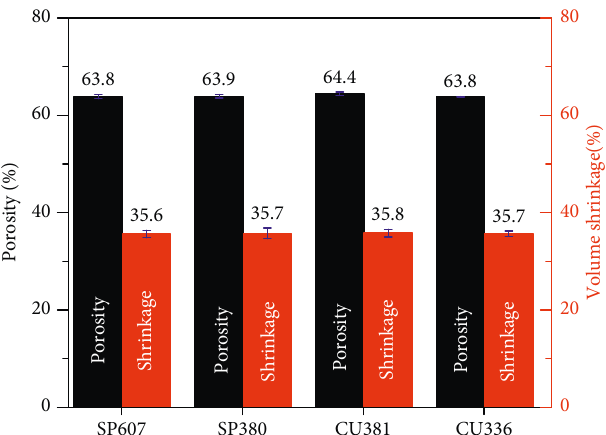
Figure 9: The relationship between the shape and size of space holder added and the final percentage of porosity and shrinkage in the sintered